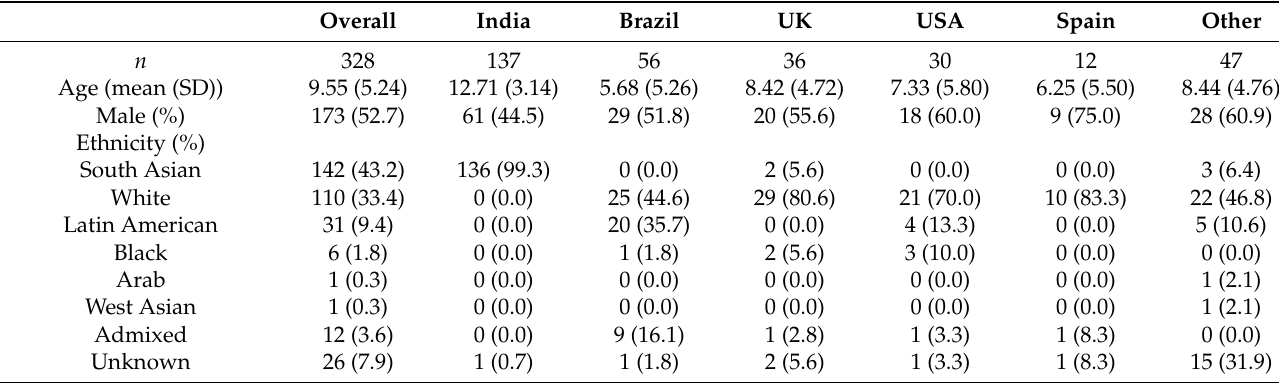
Table A2. Ethnicity of the T21RS study participants stratified by country of residence. India